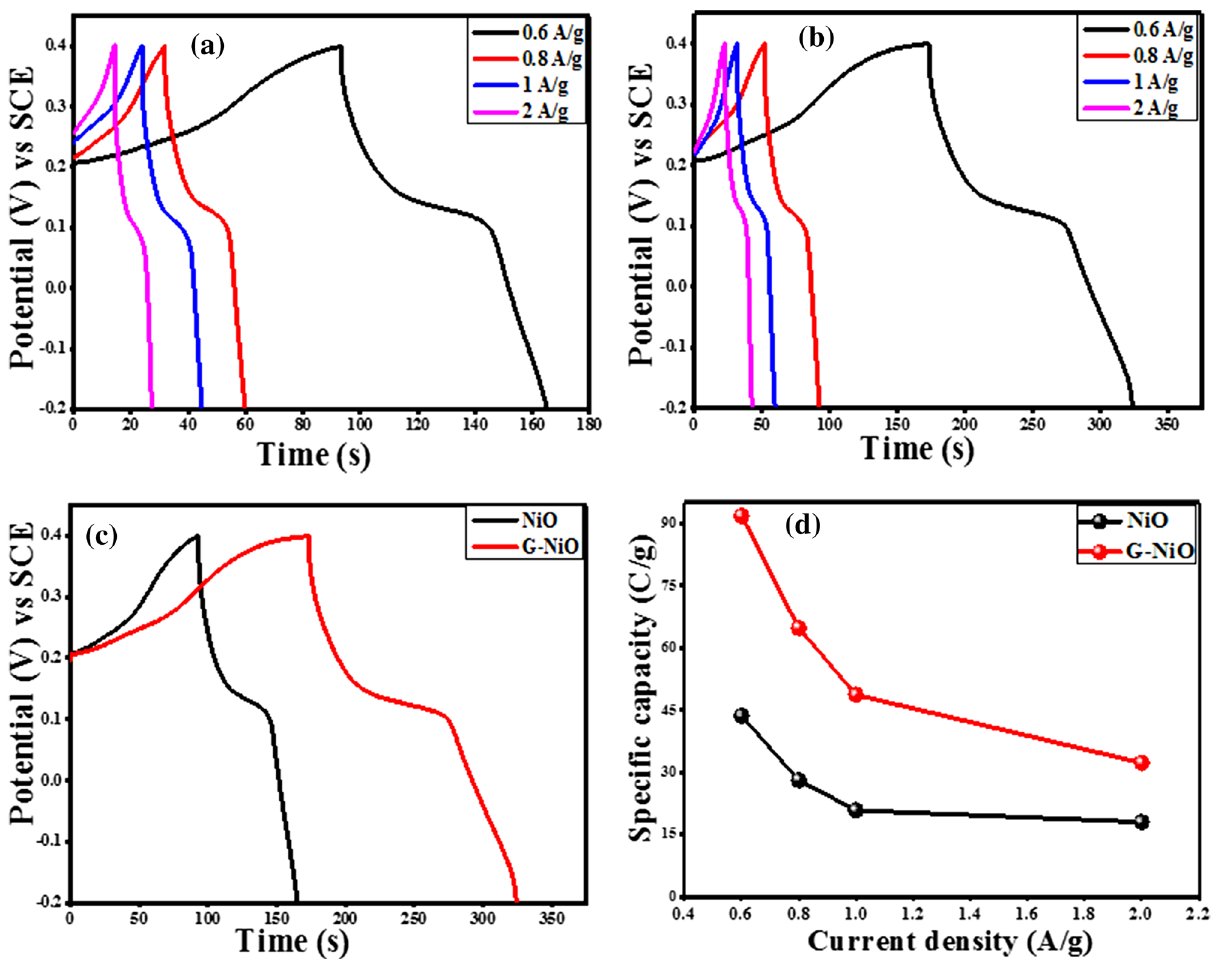
Figure 4. Galvanostatic charge–discharge plots for ( a ) NiO electrode and ( b ) G-NiO electrode at various current densities, ( c ) comparative charge–discharge plots for NiO and G-NiO at the same current density of 0.6 A g −1 , and ( d ) corresponding graphs of the specific capacity against current density for NiO and G-NiO